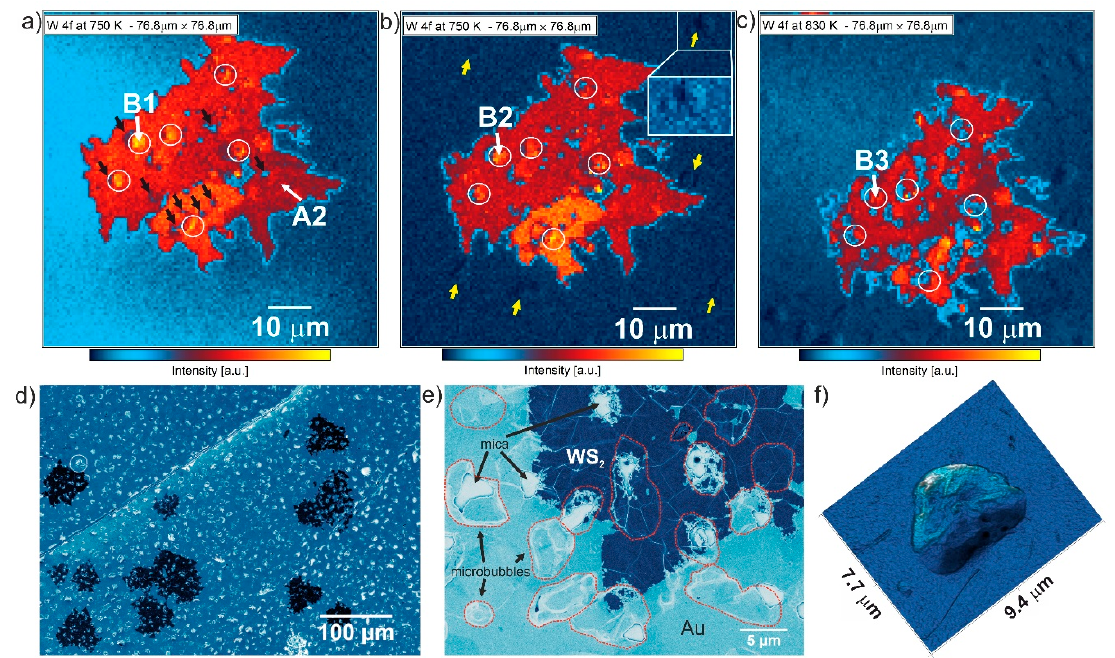
Figure 3. W 4f SPEM maps after different in situ annealing treatments: ( a ) Recorded immediately after reaching 750 K; ( b ) 750 K recorded 1 h later than ( a ); ( c ) recorded immediately after reaching 830 K. The capital letters B1, B2 and B3 indicate the points where single energy distribution curve was obtained for W 4f and S 2p. In ( b ) an insert is reported to outline the formation of lenticular gold particles (see text). ( d , e ) SEM images obtained ex situ after a thermal treatment at 830 K. ( f ) 3D SEM micrograph outlining the microbubbles generated after the annealing.